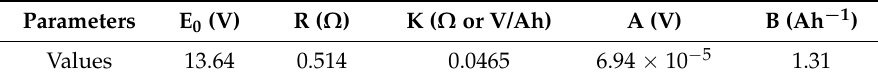
Table 2. Identified battery’s parameters.